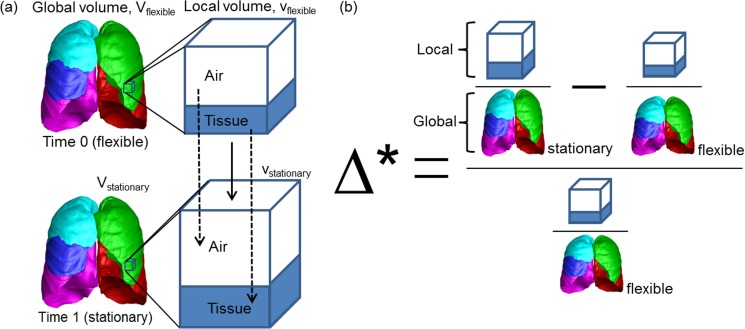
Schematic of (a) global and local lung volume changes and (b) formulation of normalized fractional volume change.